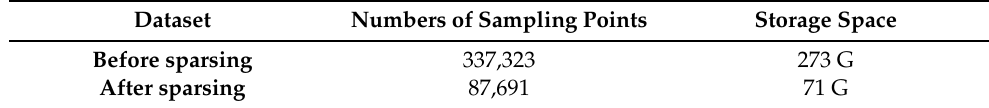
Table 1. Information of our street-level dataset before and after sparsing.